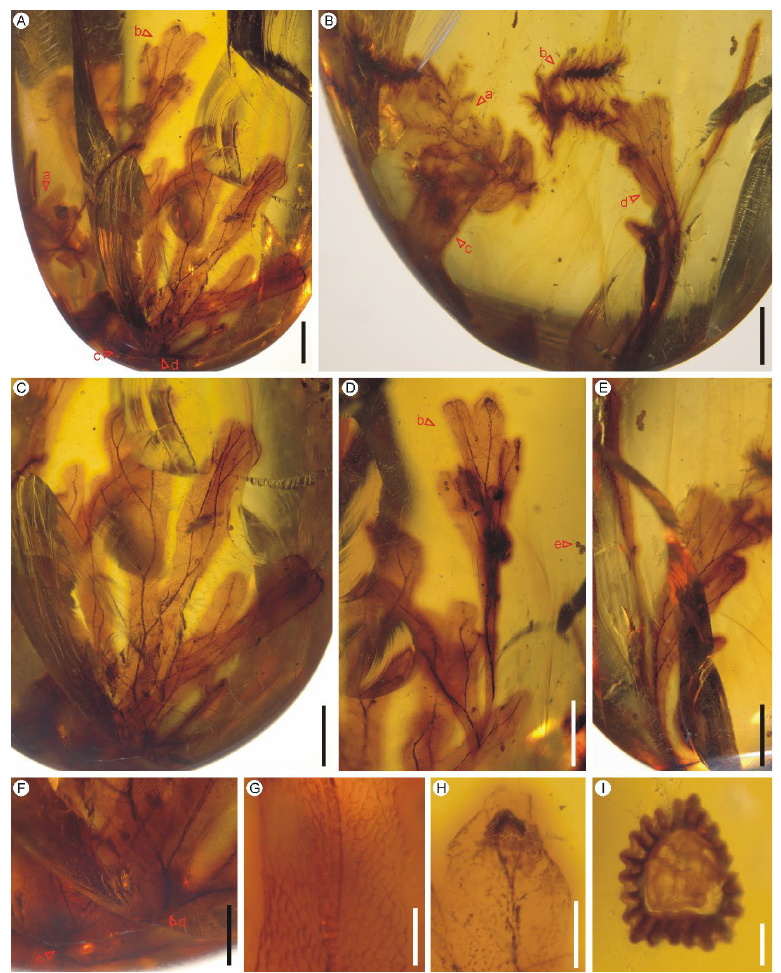
Figure 2. Hymenophyllites kachinensis sp. nov. ( A – H ) and its syninclusions ( I ) from the mid-Cretaceous Kachin amber. ( A ) The piece of amber containing three lamina fragments of Hymenophyllites kachinensis sp. nov. (PB200745b–d), as well as a sterile shoot of Selaginella (PB200745a). Scale bar = 2 mm. ( B ) The piece of amber containing two lamina fragments of Hymenophyllites kachinensis sp. nov. (PB200746c, d) and two fertile shoots of Selaginella (PB200746a, b). Scale bar = 2 mm. ( C ) The pinna or pinnule. Holotype PB18081914d. Scale bar = 2 mm. ( D ) A pinna or pinnule fragment and a sporangium. PB200745b,e. Scale bar = 2 mm. ( E ) Back view of the pinna or pinnule fragment. PB200746d. Scale bar = 2 mm. ( F ) Bases of two overlapped pinna or pinnule fragments. PB200745c,d. Scale bar = 1 mm. ( G ) Laminar cells with straight to slightly wavy cell walls. PB200745d. Scale bar = 300 μm. ( H ) A juvenile sorus born at apex of ultimate segment. PB200745b. Scale bar = 500 μm. ( I ) An accompanying sporangium. PB200745e. Scale bar = 50 μm.